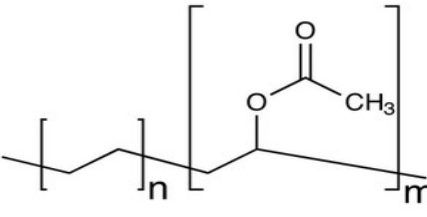
Figure 7. EVA's molecular structure. Figure 7. EVA’s molecular structure.